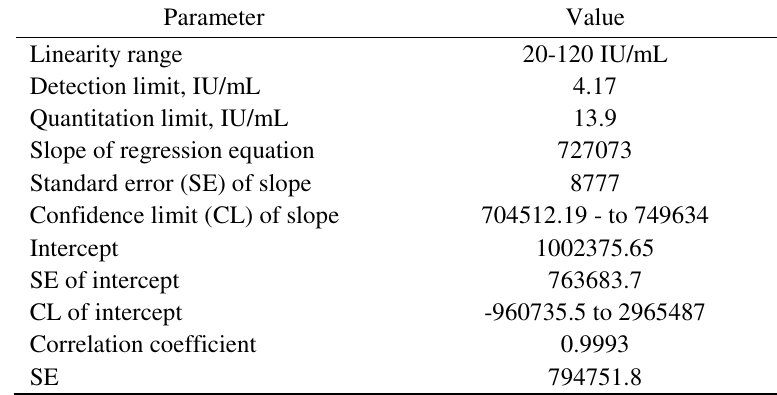
Table 3. Parameters of regression equation relating insulin concentration to analytical response (AUP)